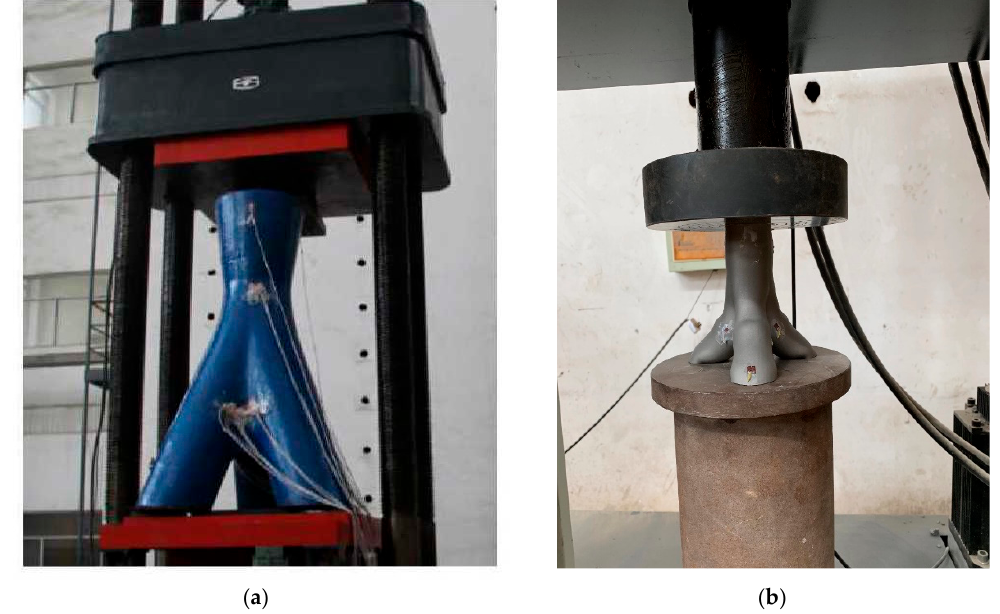
Figure 11. ( a ) Full-scale model of a cast steel bifurcation joints. ( b ) A scale model of the trifurcated steel joints made by SLM.